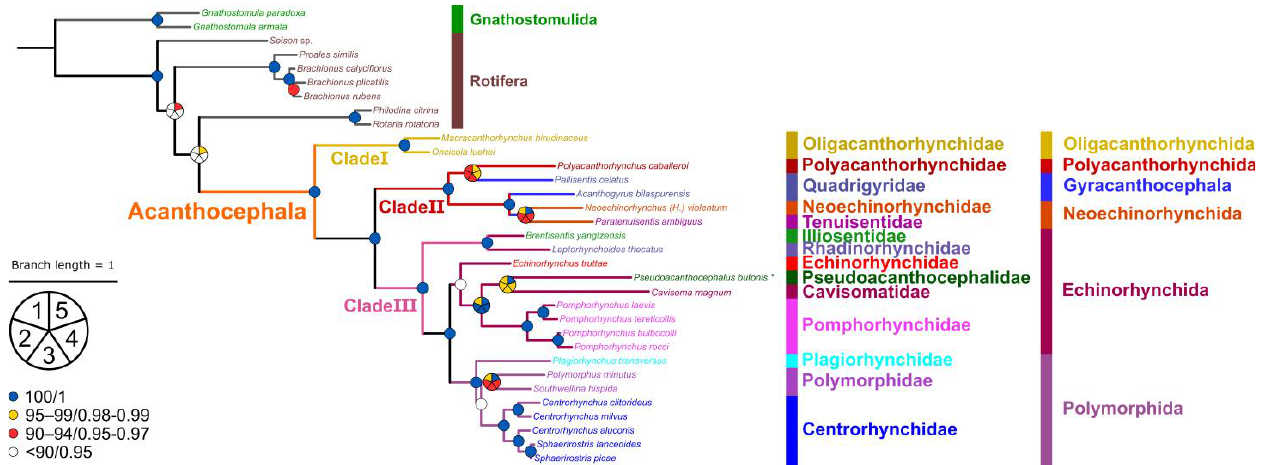
Figure 7. Phylogenetic relationships of Acanthocephala are presented based on the topology of Bayesian inference results. The branch length scale is marked according to the tree of Bayesian inference. The species followed by an asterisk (*) are sequenced in this study. Coloured circles indicate posterior probabilities/bootstrap support. Nodes of the cladogram with 0.95–0.97/90–94 are labelled orange; 0.98–0.99/95–99 by blue; 1/100 by green. Nodes divided into five parts indicate the different supports of five methods: (1) Bootstrap support of ML methods with no partition (NP) scheme under the mtZOA + F + R5 model; (2) with full partition (FP) scheme; (3) with merged partition (MP) scheme; (4): Bootstrap support of ML methods under the mtZOA + F + R5 + C60 model; and (5) Posterior probabilities of Bayesian inference.